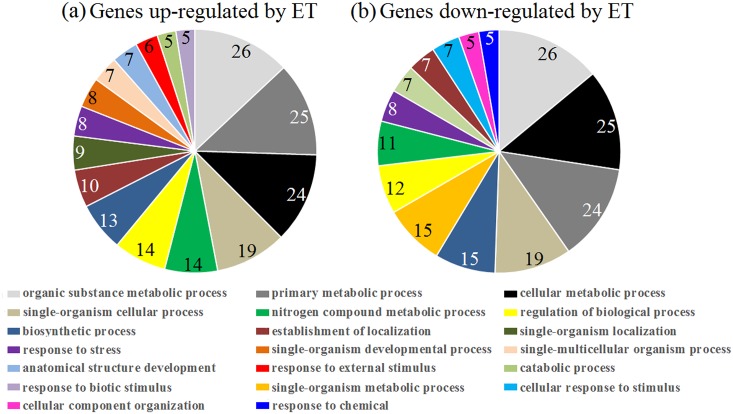
GO terms belonging to the biological process domain attributed to ET-responsive genes in the latex.(a) GO term classification of ET-responsive genes with fold-change values ≥ 2 (q-value < 0.05) (b) GO term classification of ET-responsive genes with fold-change values ≤ –2 (q-value < 0.05). GO term classifications populated by at least five genes were shown, and the number of genes annotated within each term was indicated.